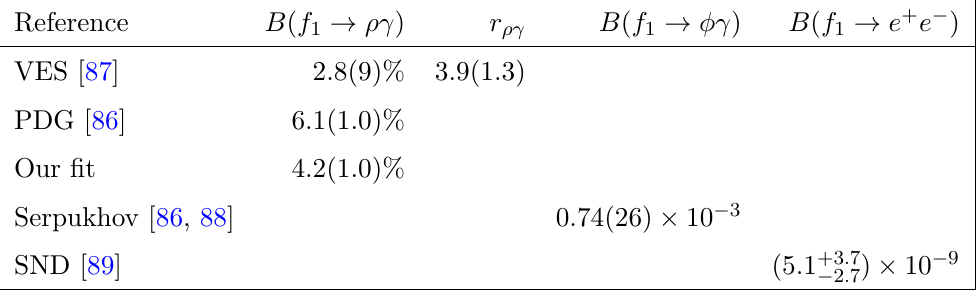
Table 7 . Summary of the experimental measurements used in our global analysis. In addition, we use the L3 data for e + e − → e + e − f 1 , see section